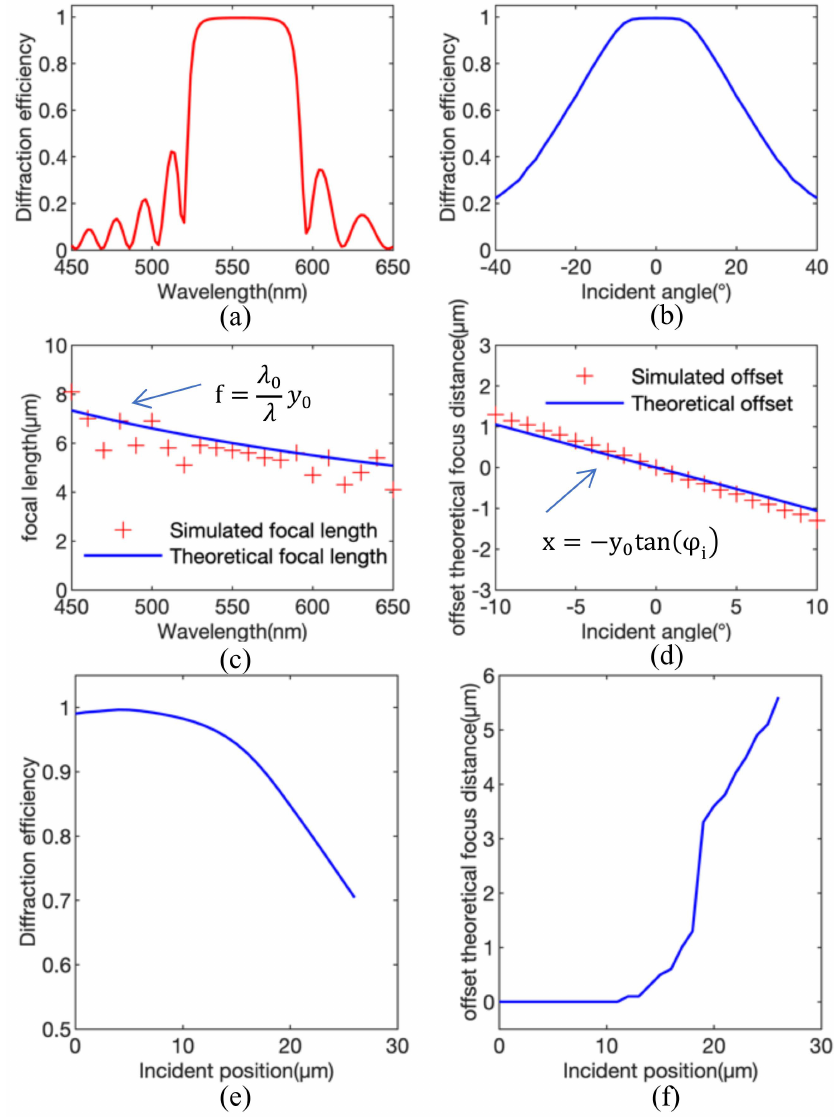
Figure 3. Diffraction properties of an ideal PVL. ( a – d ) Diffraction efficiency and focus position as a function of incident angle and wavelength. The red dotted line in ( b ) shows the range of angle in ( d ). The theoretical curves are derived from the PVL’s dispersion equation. ( e , f ) Diffraction efficiency and focus position as a function of incident position of